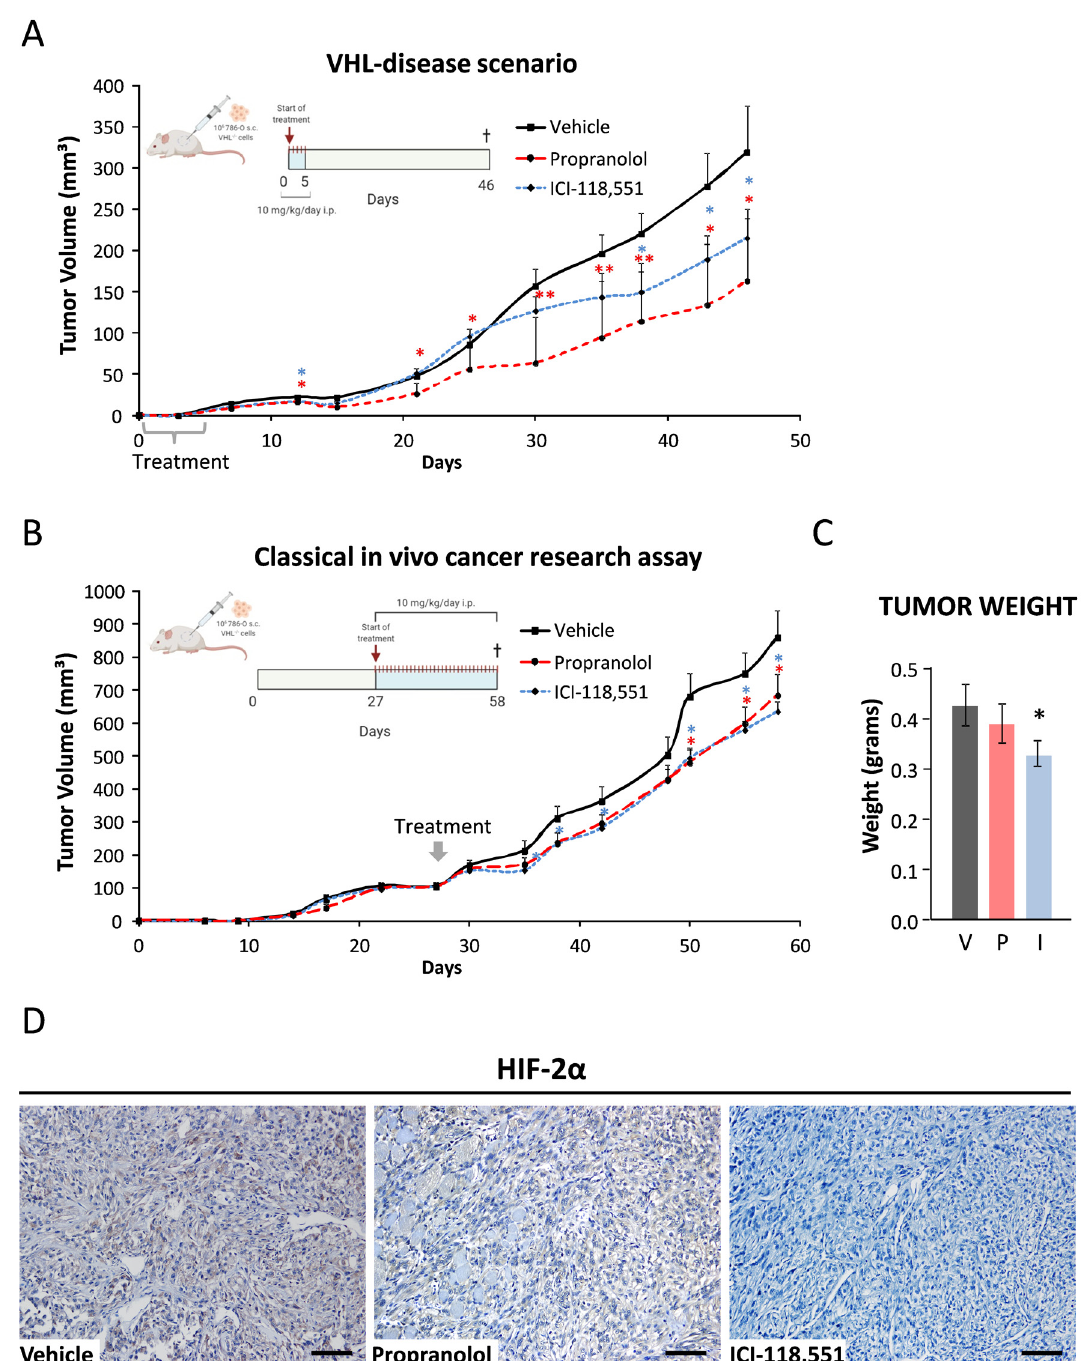
Figure 5. Inhibition of tumor growth by ADRB antagonists. Tumor volumes reached after subcutaneous injections of 10 6 786-O wild type cells (n = 9–10) and intraperitoneal treatment with 10 mg / Kg / day Vehicle ( (cid:4) ), propranolol ( • ), or ICI ( (cid:7) ), in 10–12-week-old male NOD / SCID mice. ( A ). (VHL-disease scenario) Systemic treatment started along the first five days after tumor implantation; or ( B ). (Classical in vivo cancer research assay) when average tumor reached 100 mm 3 volume. ( C ). Average weights of the collected tumors. ( D ). Immunohistochemical detection of HIF-2 α in the ccRCC 786-O tumor xenografts. Cell nuclei were counterstained with hematoxylin. Scale bars represent 100 µ m. ( C , D ) belong to the “( B ). Classical in vivo cancer research assay” approach. Abbreviations: V, P, and I for vehicle, propranolol, and ICI, respectively. Error bars denote ± SEM for each time. Student’s t -test: * p < 0.05; ** p < 0.01; *** p < 0.001.